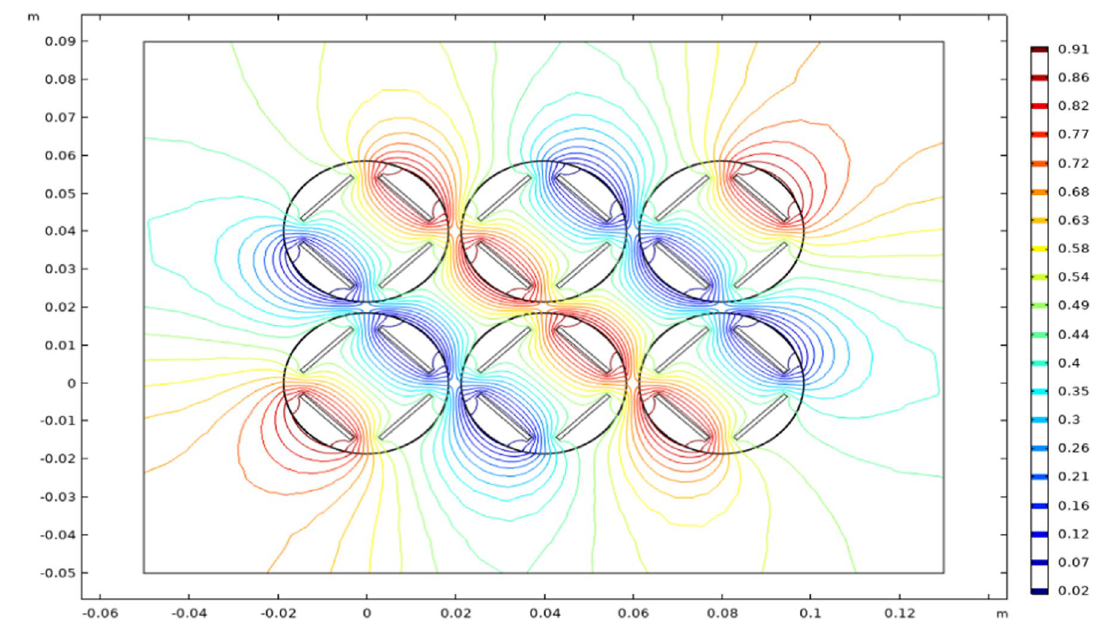
Fig. 3 2D contour plot of simulated electric potential. The model showed a uniformity of the electric field between each well. A region of roughly uniform field shape was identified in the center of each well as a site for cell culture. This uniformity also shows that electric fields within each well do not affect those in other